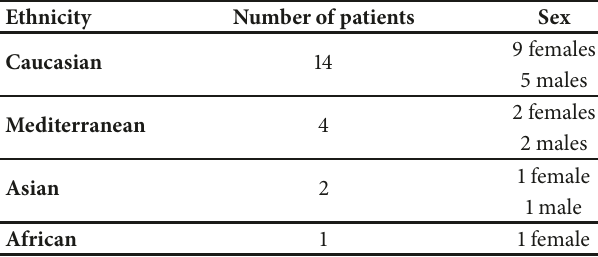
Table 1: Ethnicity and sex of patients.